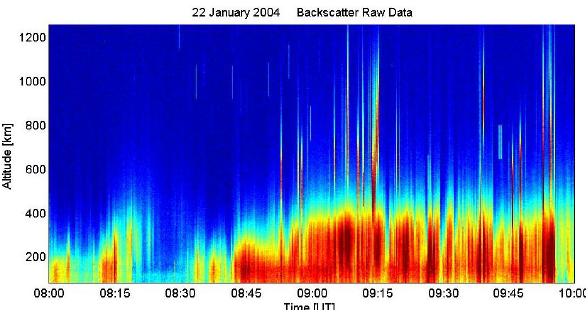
Fig. 1. ESR backscatter versus time and altitude. Red represents strong backscattering. Some of the NEIAL events can be seen as extended vertical lines in F-region, often coinciding with increased backscattering in the E-region. Good examples of this can be seen ∼ 09:38, ∼ 09:48 and ∼ 09:52–09:52:55 UT, and more moderate cases can be seen ∼ 08:53, ∼ 09:10 and ∼